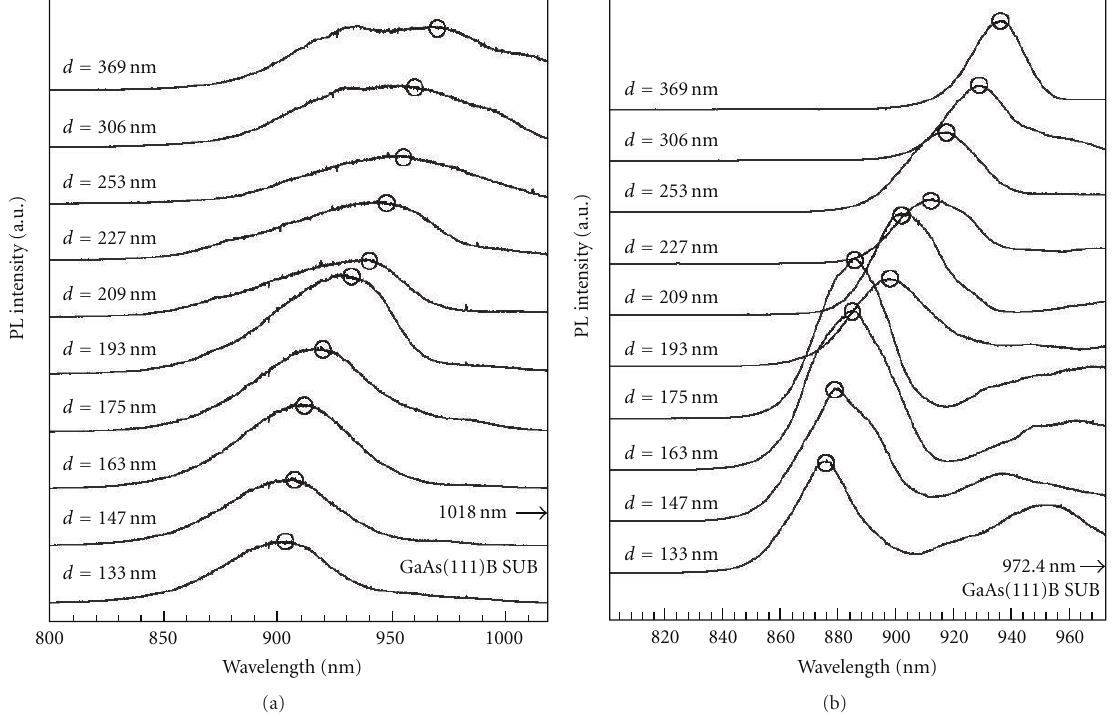
Figure 5: (a) Micro-PL spectra for sample II at RT and (b) at 77K [28]. Open circles indicate the emission peaks of